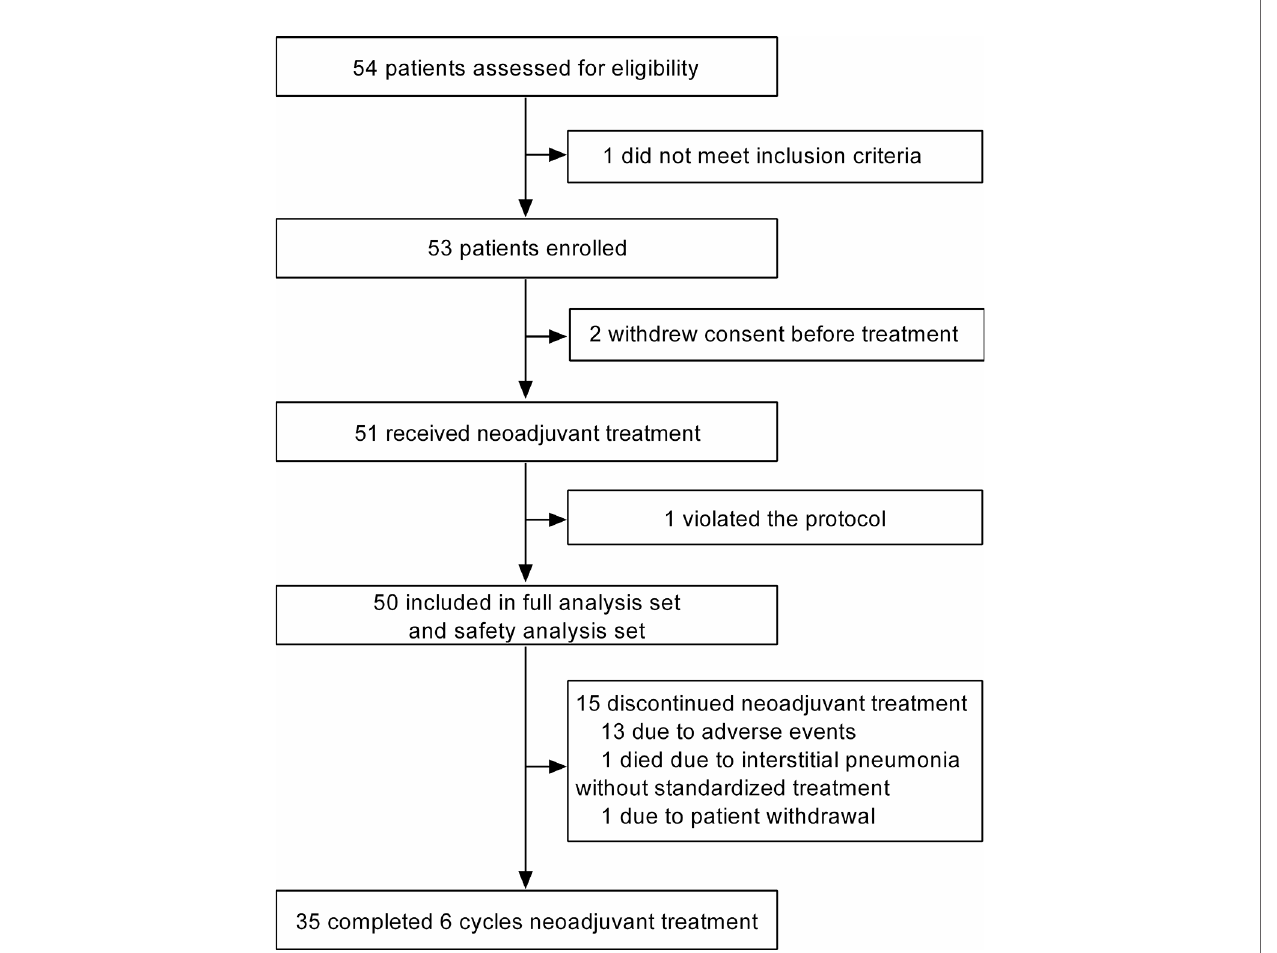
FIGURE 1 | Trial pro fi